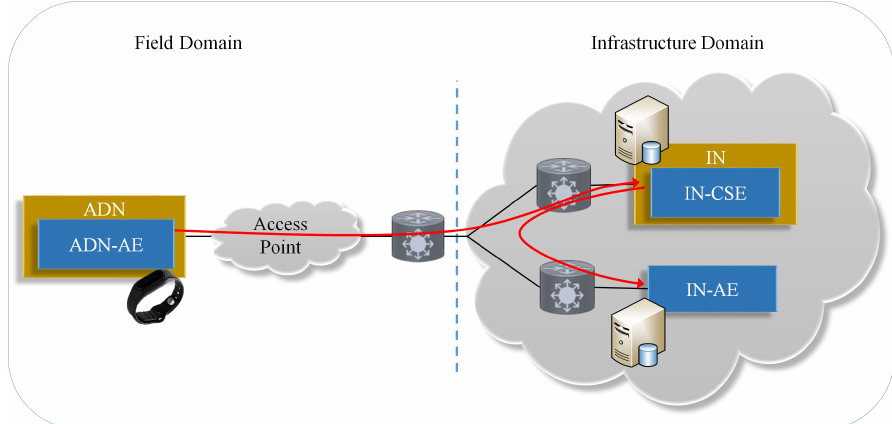
Figure 2. System architecture using standardized oneM2M entities. The oneM2M system is divided in two domains: Field and Infrastructure. The Application Dedicated Node (ADN) contains an Application Entity (AE) that implements the service logic. The Infrastructure Node (IN) holds a Common Service Entity (CSE). The IN-AE is an AE that is registered with the CSE in the IN. Both ADN-AE and IN-AE communicate over the Mca reference point with the IN-CSE. Red arrows represent user data